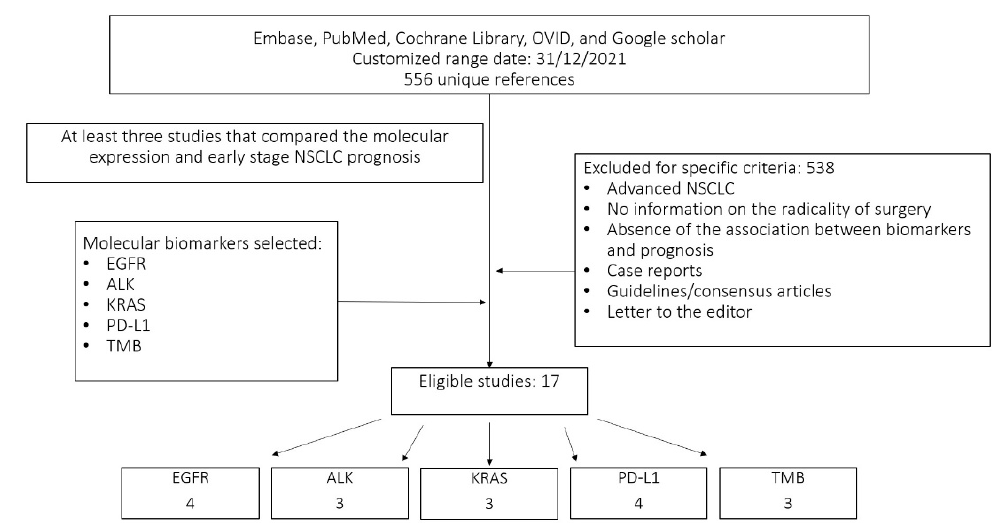
Figure 1. Flow diagram for the evaluated studies.